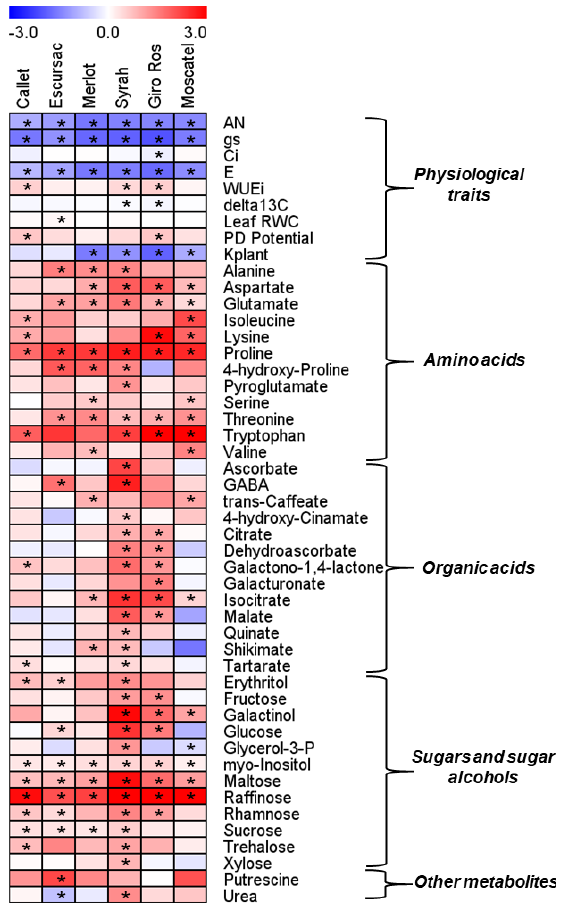
Figure 1. Heatmap of the physiological and metabolic responses to water deficit stress in all grapevine cultivars. Values are log2 transformed fold-changes calculated from water deficit stress (WDS) / well-watered (WW) ratios. The physiological parameters and metabolites shown were selected to have statistically significant ( p < 0.05) di ff erences between WDS and WW conditions in at least one of the cultivars. Asterisks denote significant changes ( p < 0.05) determined after t -test comparisons between WDS and WW conditions. For abbreviations information see Table